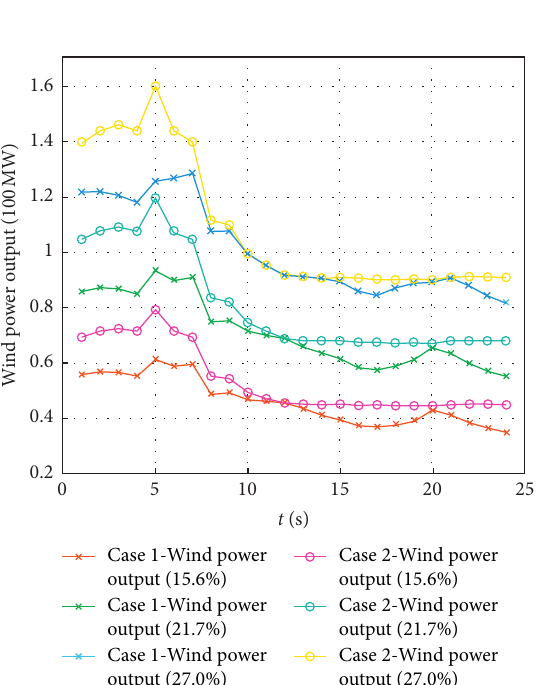
Figure 3: Comparison of actual wind output in two cases under different wind penetration rates.